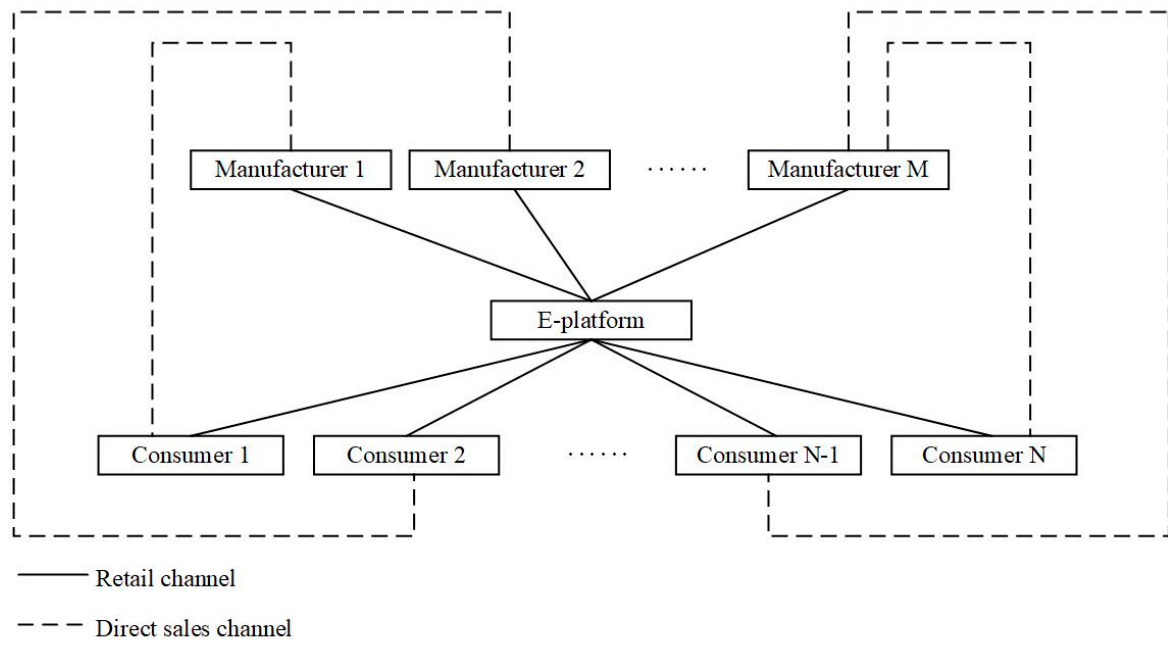
Figure 1. Different sales modes.